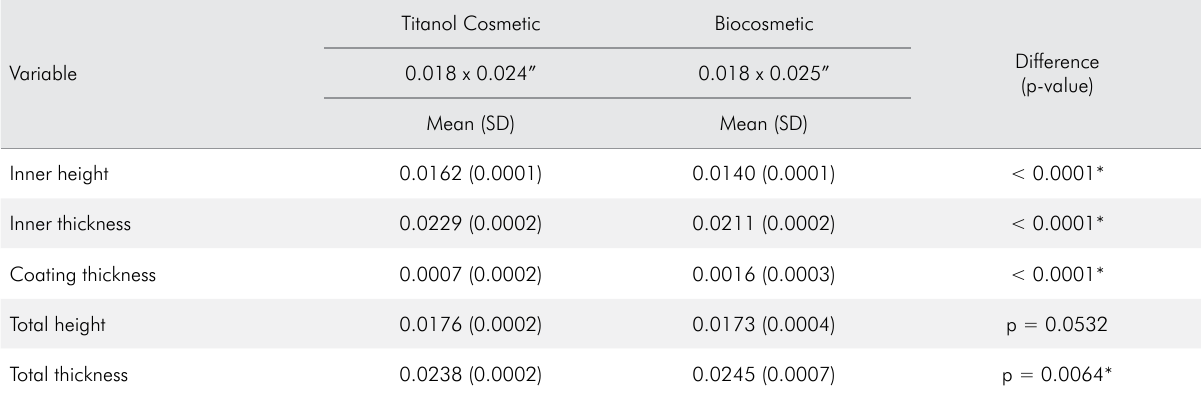
Table 1. Wire dimensions, coating thickness, and statistical differences for as received wires.